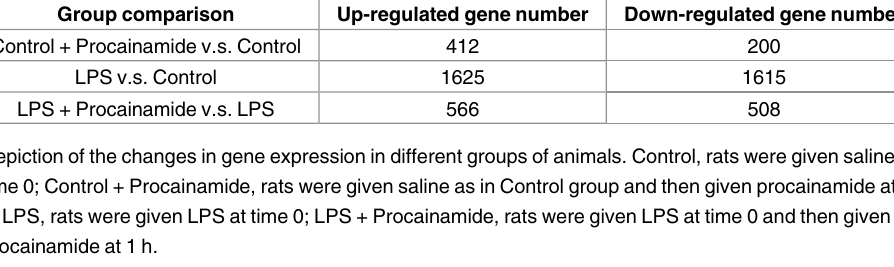
Table 3. Effects of procainamide on gene expression in LPS-induced endotoxemic rats. Group comparison